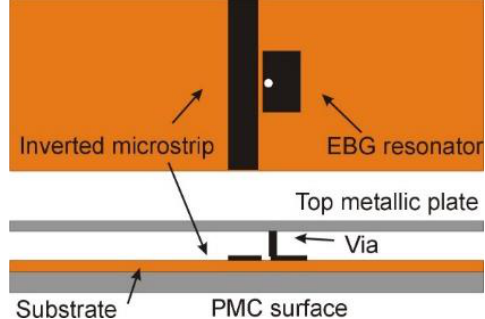
Figure 1. Proposed configuration for the coplanar loaded resonator in inverted microstrip gap waveguide technology.